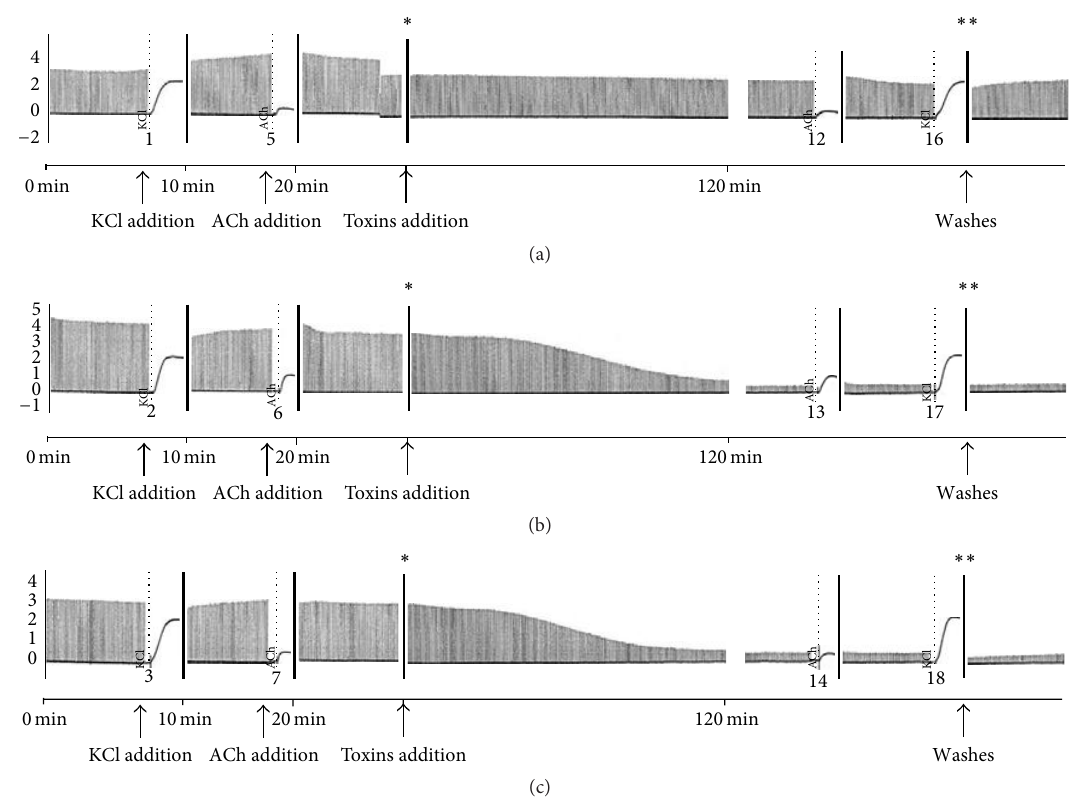
Figure 2: Chick biventer cervicis preparations in Krebs (control, (a)), or incubated with 10 𝜇 g/mL of BmjeTX-I (b) and with 10 𝜇 g/mL of BmjeTX-II (c) toxins isolated from B. marajoensis crude venom. Notice, in (b) and (c), the irreversible neuromuscular blockade induced after 31.2 ± 3.5 min and 30 ± 8.1 min ( 𝑝 < 0.05 from Krebs) of toxins ( ∗ ) addition, respectively. ACh and KCl addition; ∗∗ : washes ( 𝑛 = 12 for each